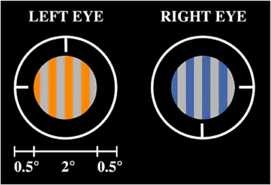
Hong and Shevell [16] stimuli